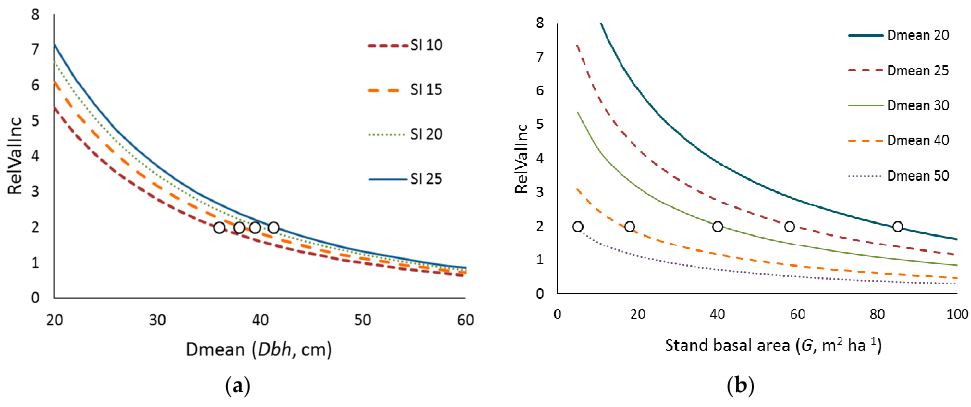
Figure 3. ( a ): Relative value increment as a function of site index ( SI ) and mean diameter ( D mean ) when stand basal area ( G ) is 25 m 2 ha − 1 . The dots indicate the diameter at which the stand is financially mature (i.e., above 2% in our study) and so, ready for final felling; ( b ): Relative value increment ( RelValInc ) for SI 10 m as a function of G and D mean . The dots define the basal area values at final felling is proposed. Examples of alternative mean tree diameters for the particular site index are shown.